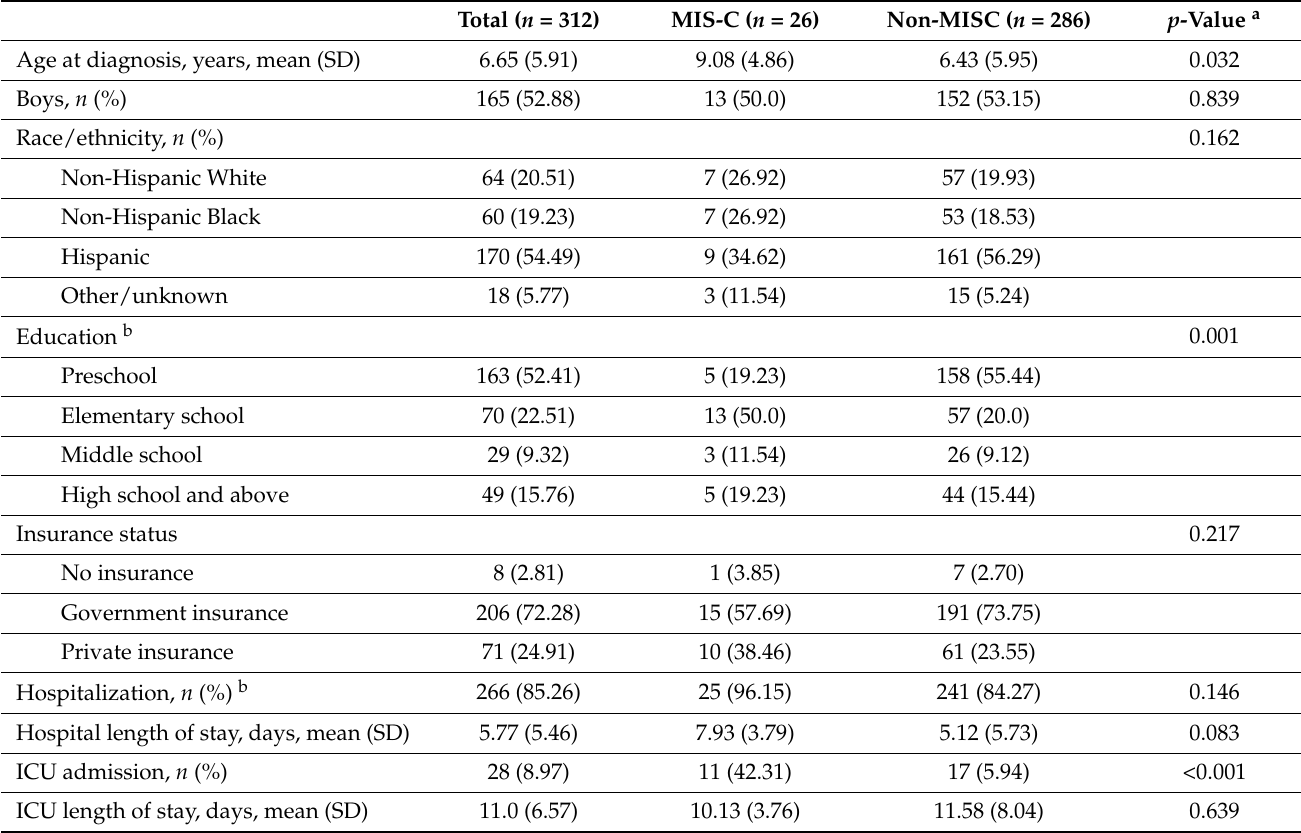
Table 1. Baseline characteristics by MIS-C status ( n =